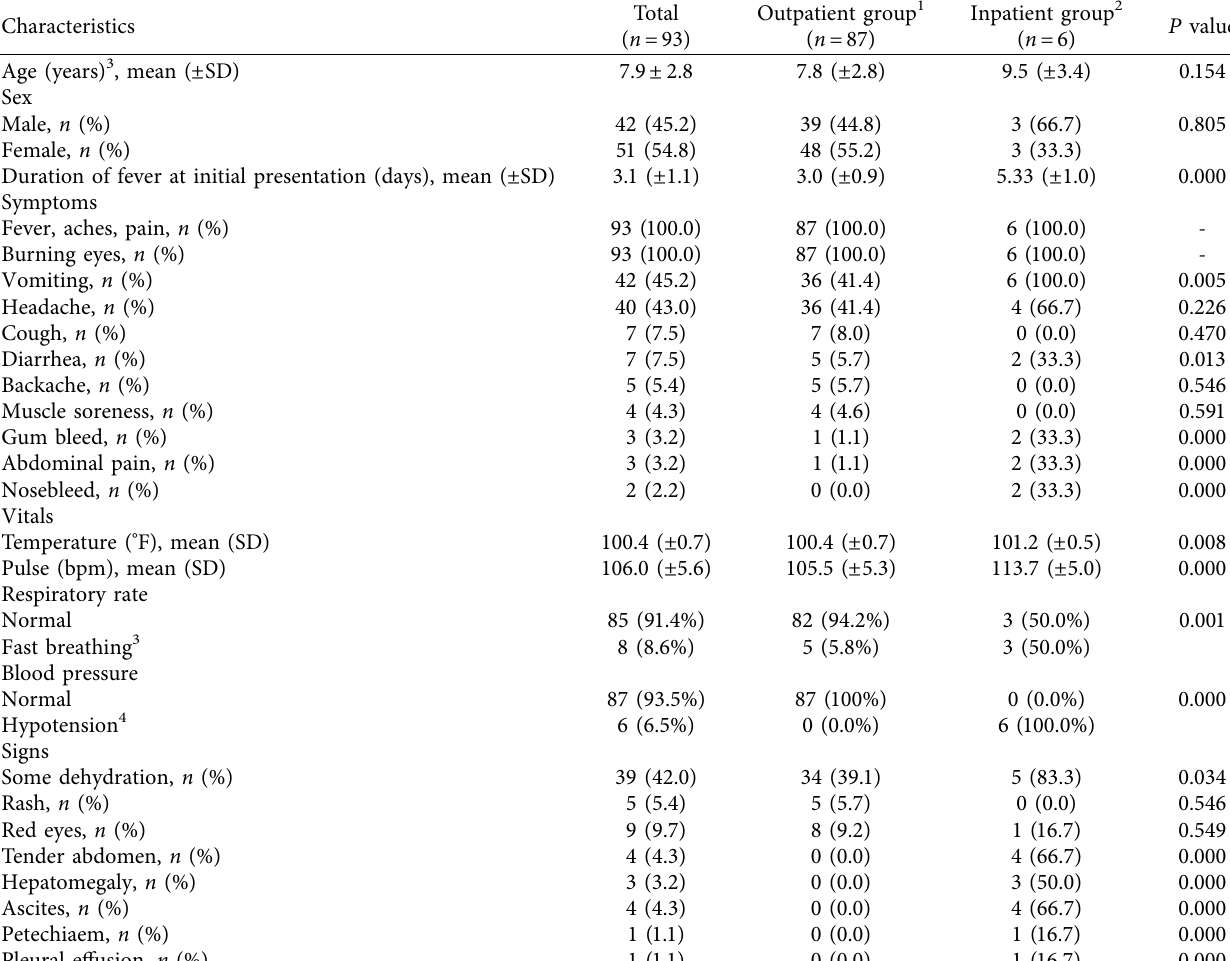
Table 1: Comparison of baseline characteristics and clinical features of patients at initial